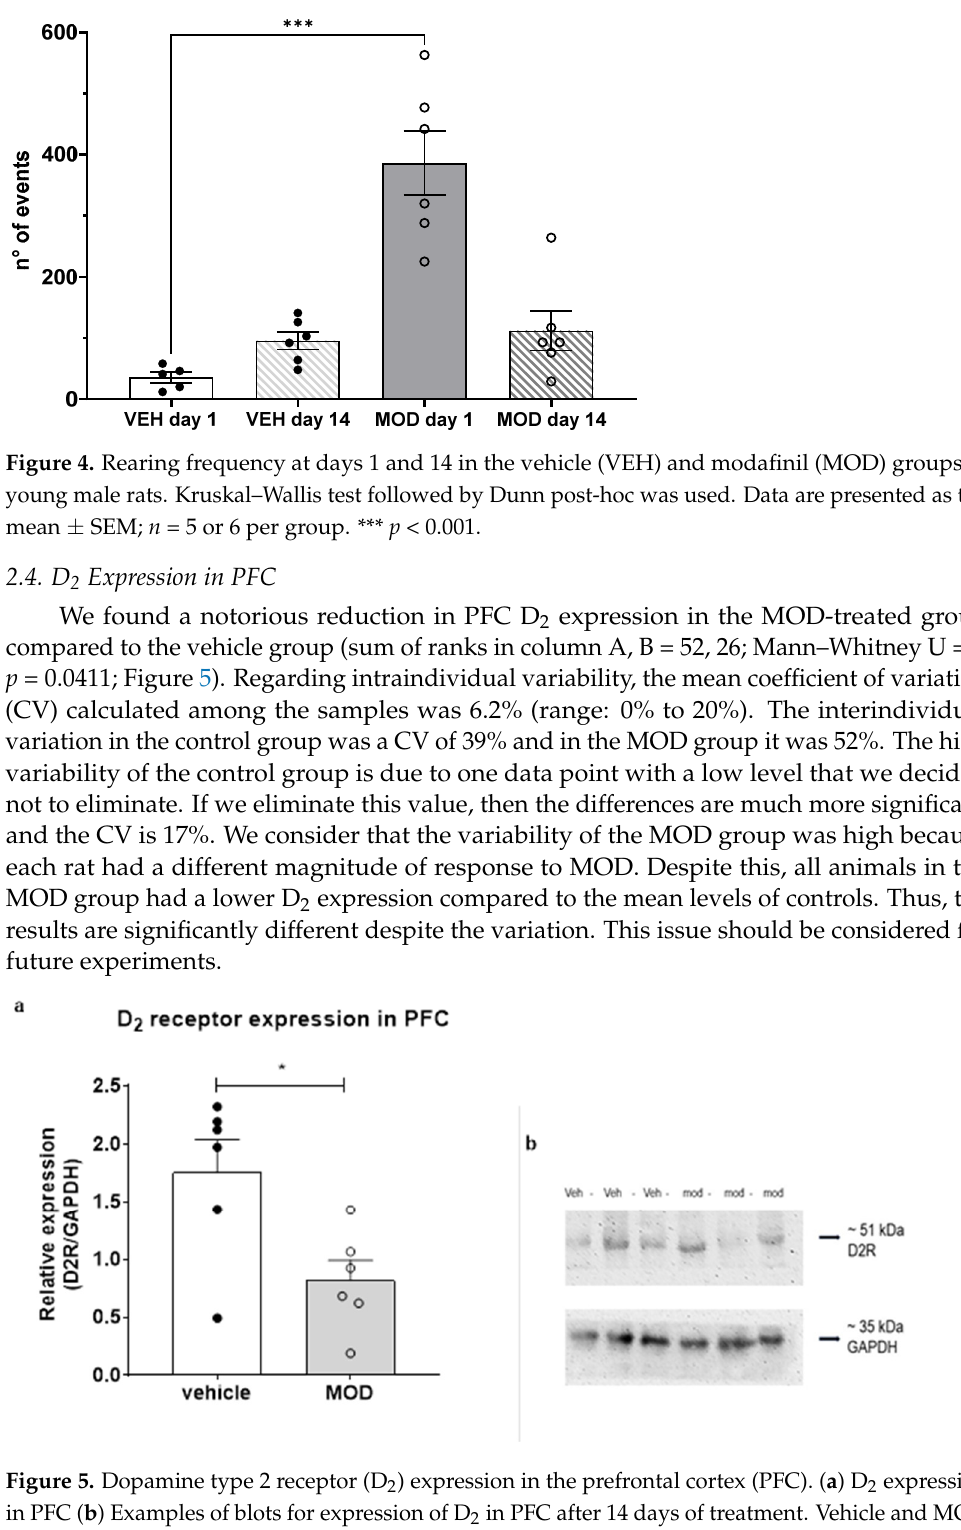
Figure 3. Non-selective attention (NSA) at day 1 and day 14 after vehicle (VEH) or modafinil (MOD) treatment in young male rats in 60 min test. Kruskal–Wallis test followed by Dunn post-hoc was used. Data are presented as the mean ± SEM; n = 5 or 6 per group. * p < 0.05.